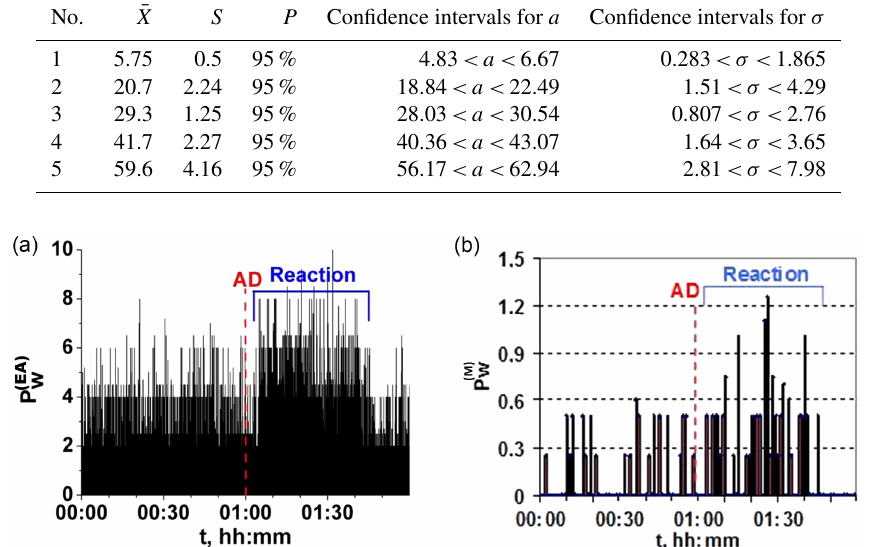
Table 1. Time delay variations in the detected atmospheric effects: confidence intervals for the probability distribution a and mean square deviations σ , in minutes. Confidence intervals for a